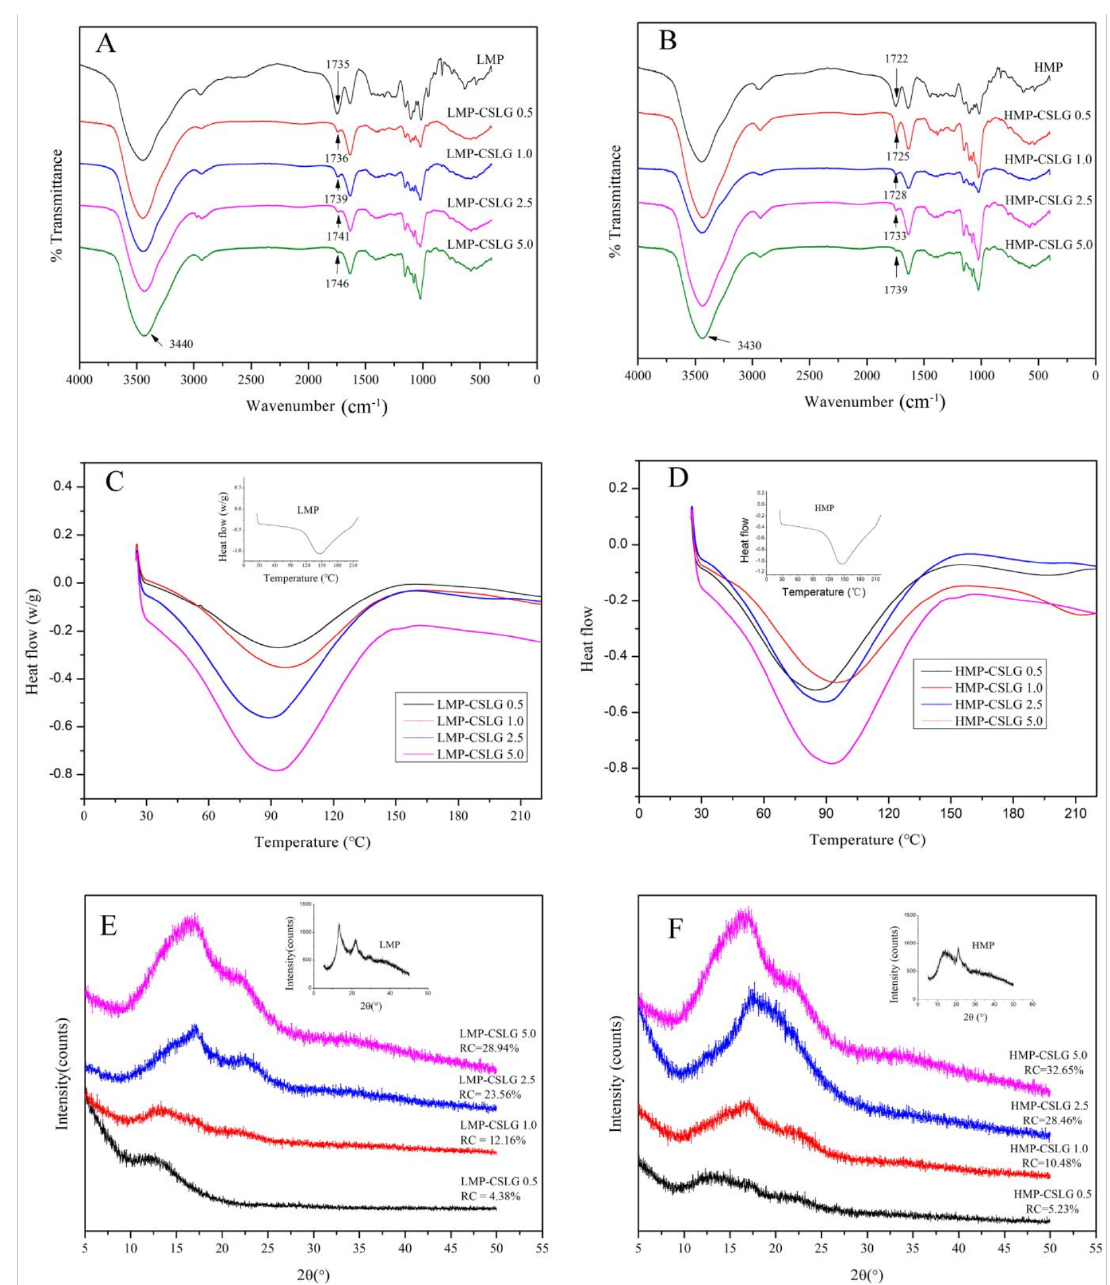
Figure 4. ( A ) FTIR spectra of LMP and LMP-CSLG nanocomplex with different CSLG concentration (0.5, 1.0, 2.5, and 5 mg/mL) ( B ) FTIR spectra of HMP and HMP-CSLG nanocomplex with different CSLG concentration; ( C ) The DSC curves of LMP and LMP-CSLG nanocomplex with different CSLG concentration; ( D ) HMP and HMP-CSLG nanocomplex with different CSLG concentration; ( E ) X-ray spectra of LMP and LMP-CSLG nanocomplex with different CSLG concentration; ( F ) X-ray spectra of HMP and HMP-CSLG nanocomplex with different CSLG concentration. Fourier transform infrared spectroscopy (FTIR); Differential Scanning Calorimetry (DSC); low methoxyl pectin (LMP); Cationic short linear glucan (CSLG); high methoxyl pectin